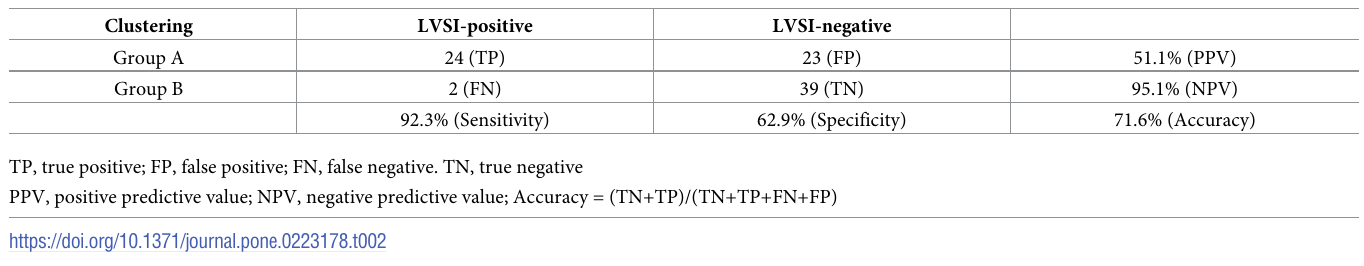
Table 2. Diagnostic performance of the 55-gene